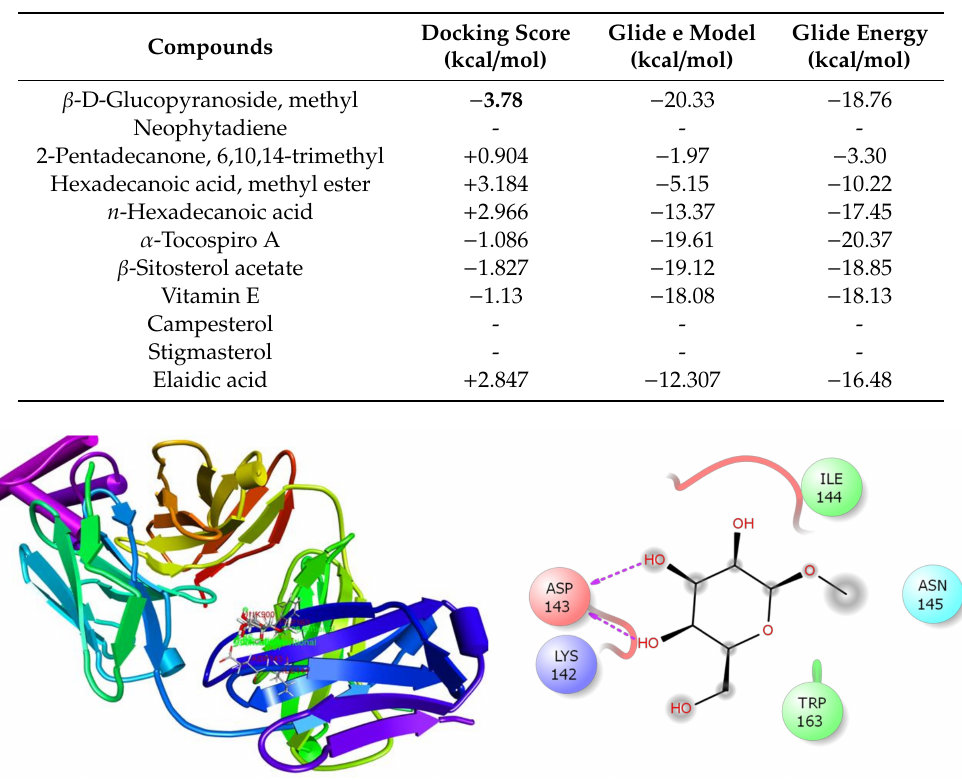
Figure 7. Best ranked poses and 2D interactions of β -D-Glucopyranoside, methyl with potassium channel (pdb: 4UUJ) for anxiolytic